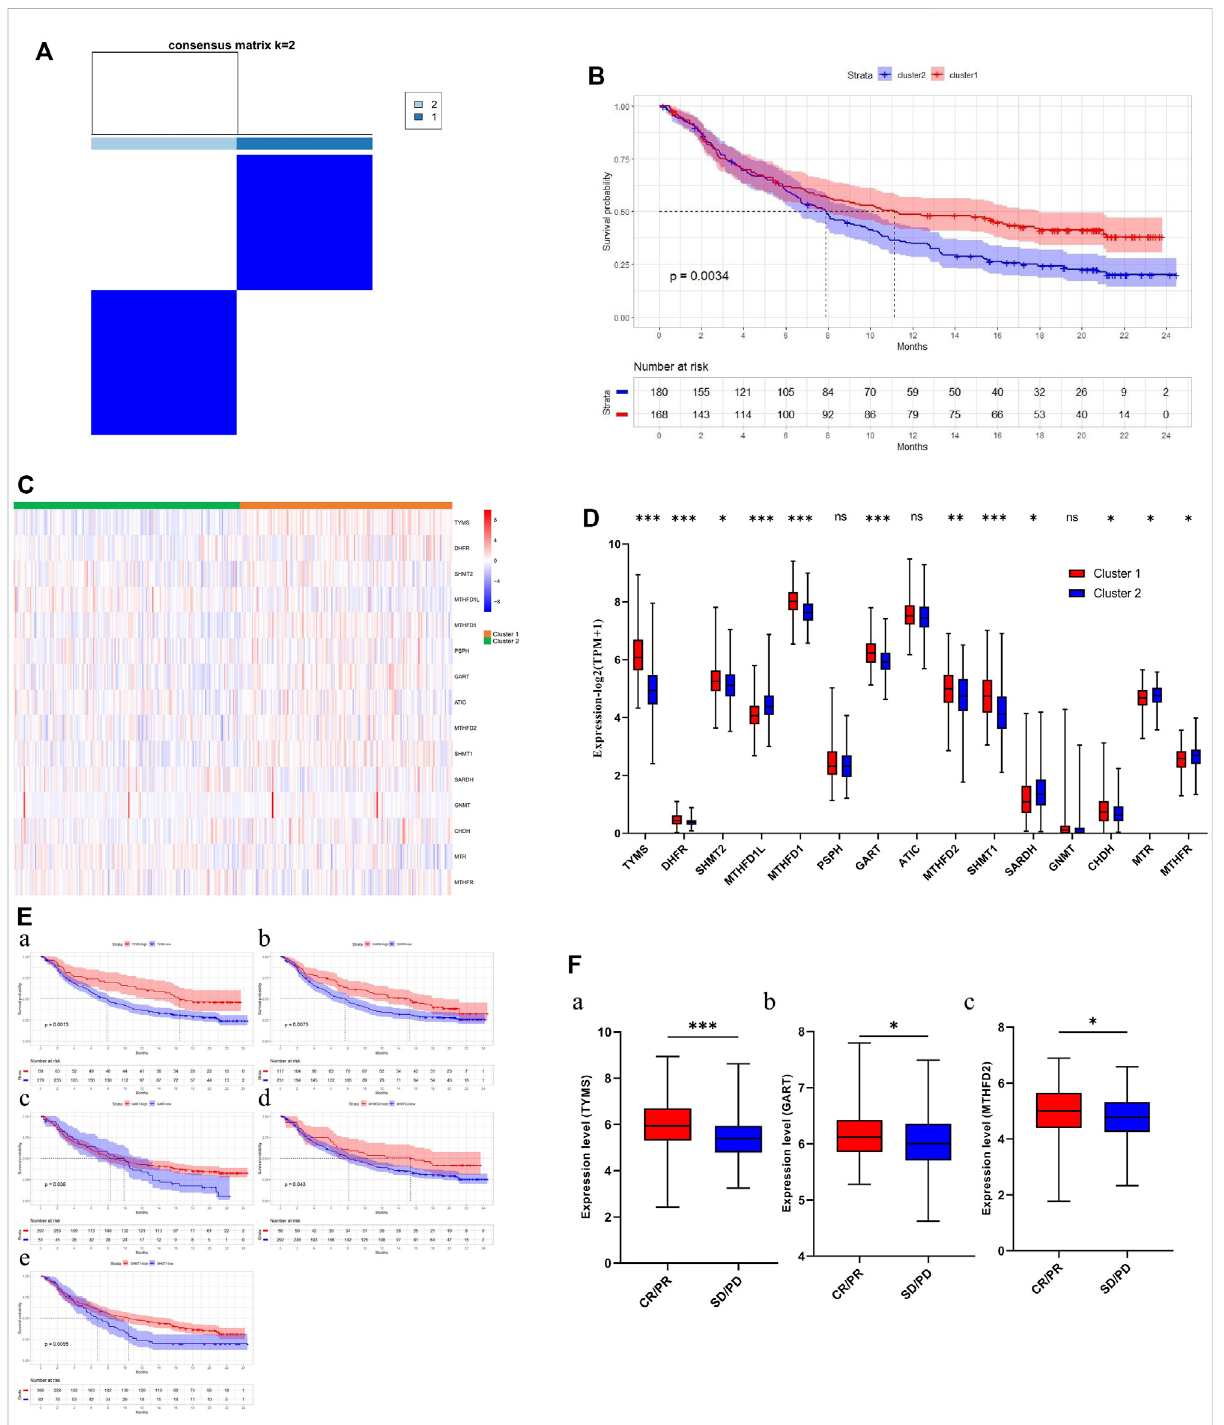
FIGURE 8 Association of one-carbon metabolism related genes with immunotherapy. (A) The consensus matrix shows patients with two distinct one- carbon metabolism statuses; (B) Kaplan-Meier curves for overall survival in two clusters (Log-rank test); (C) Heatmap of one-carbon metabolism associated genes expression level in two clusters; (D) The expression difference of one-carbon metabolism associated genes in two clusters; (E) Kaplan-Meier survival curves of fi ve genes associated with superior OS; (F) The expression difference of three one-carbon metabolism associated genes between CR/PR group and SD/PD group. * means p < 0.05; ** means p < 0.01; *** means p < 0.001; ns means no signi fi cant